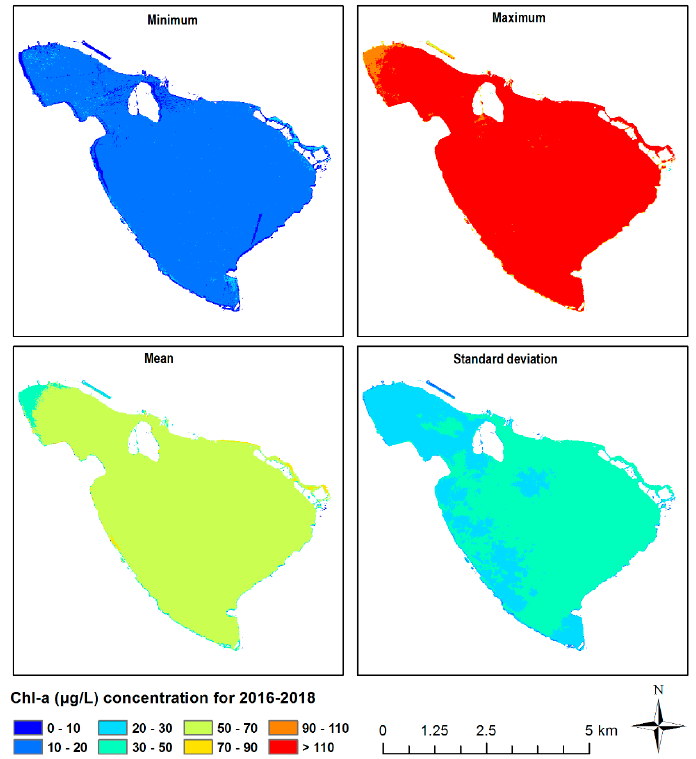
ISPRS Int. J. Geo-Inf. 2020 , 9 , 143 Figure A4. Chl- a concentration for 2016–2018. Figure A4. Chl- a concentration for 2016–2018.